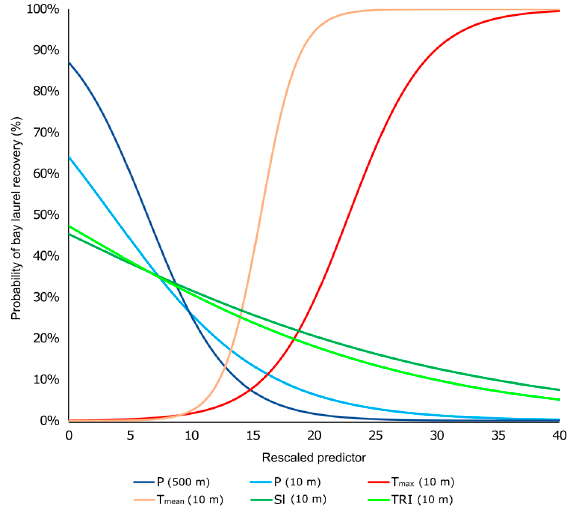
Figure 6. Graphs of the logistic equations modelling the probability of bay laurel recovery based on the single significant predictors detected in scenario ‐ 500 m (500 m) and scenario ‐ 10 m (10 m). The abscissa (rescaled predictor) represents each factor eventually rescaled so that one unit equals: 100 mm for precipitations (P), 1 °C for temperatures (T), 1% for slope (Sl) and 10 points of terrain ruggedness index (TRI). For more details about factors acronyms, see the main text.